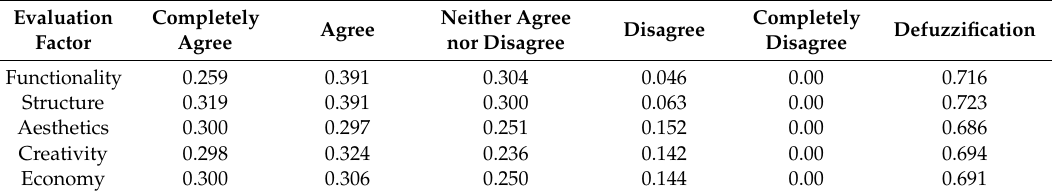
Table 5. Degrees of conformity of various factors determined by interviewees.